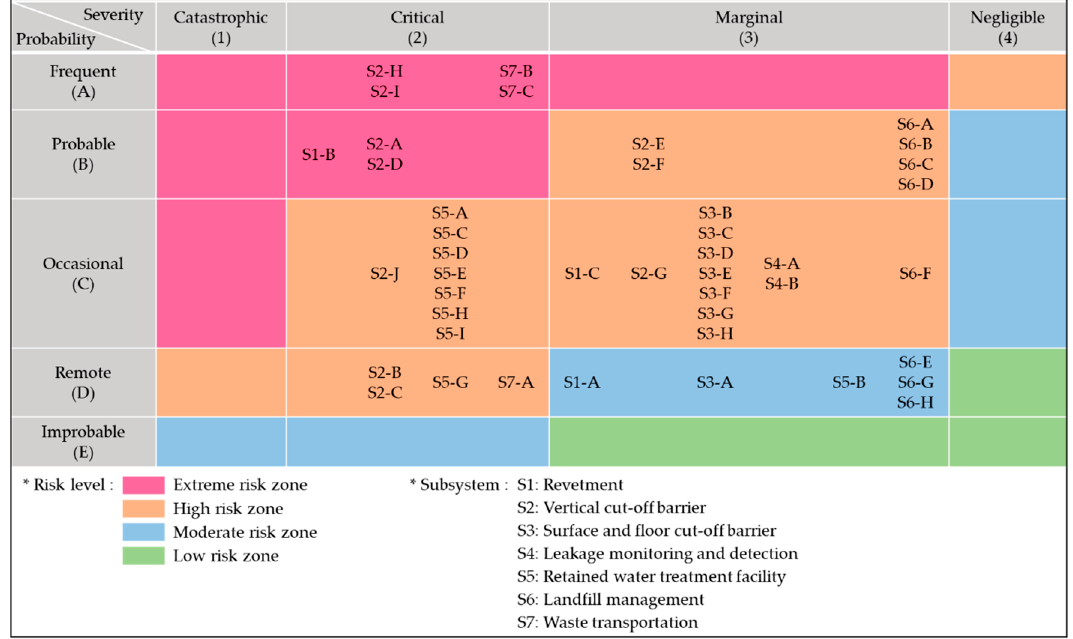
Figure 6. Risk assessment matrix of initial subsystem hazard analysis (SSHA) of the offshore waste disposal facility.